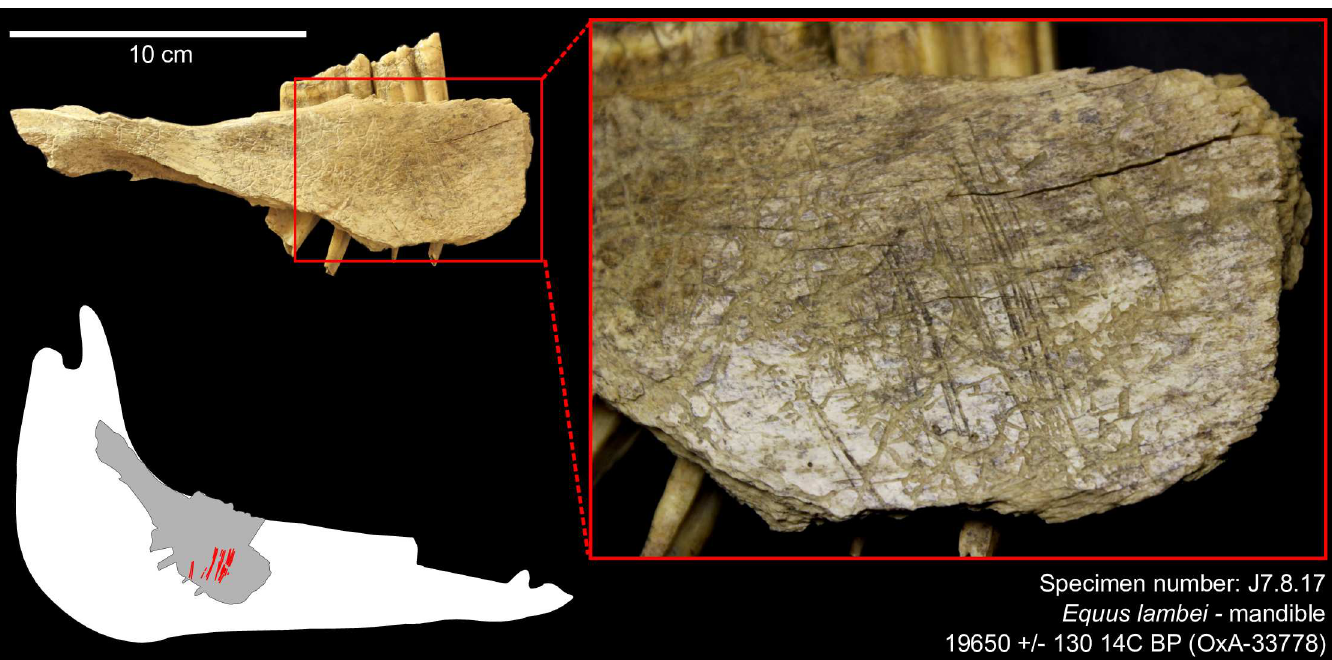
Fig 1. Cut markson a horse mandible from Cave II. The specimen(# J7.8.17) is dated to 19,650 ± 130 14 C BP (OxA-33778). The bone surface is a bit weathered and altered by root etchingbut the cut marks are well preserved; they are locatedon the medial side, under the third and second molars, and are associatedwith the removalof the tongue using a stone tool